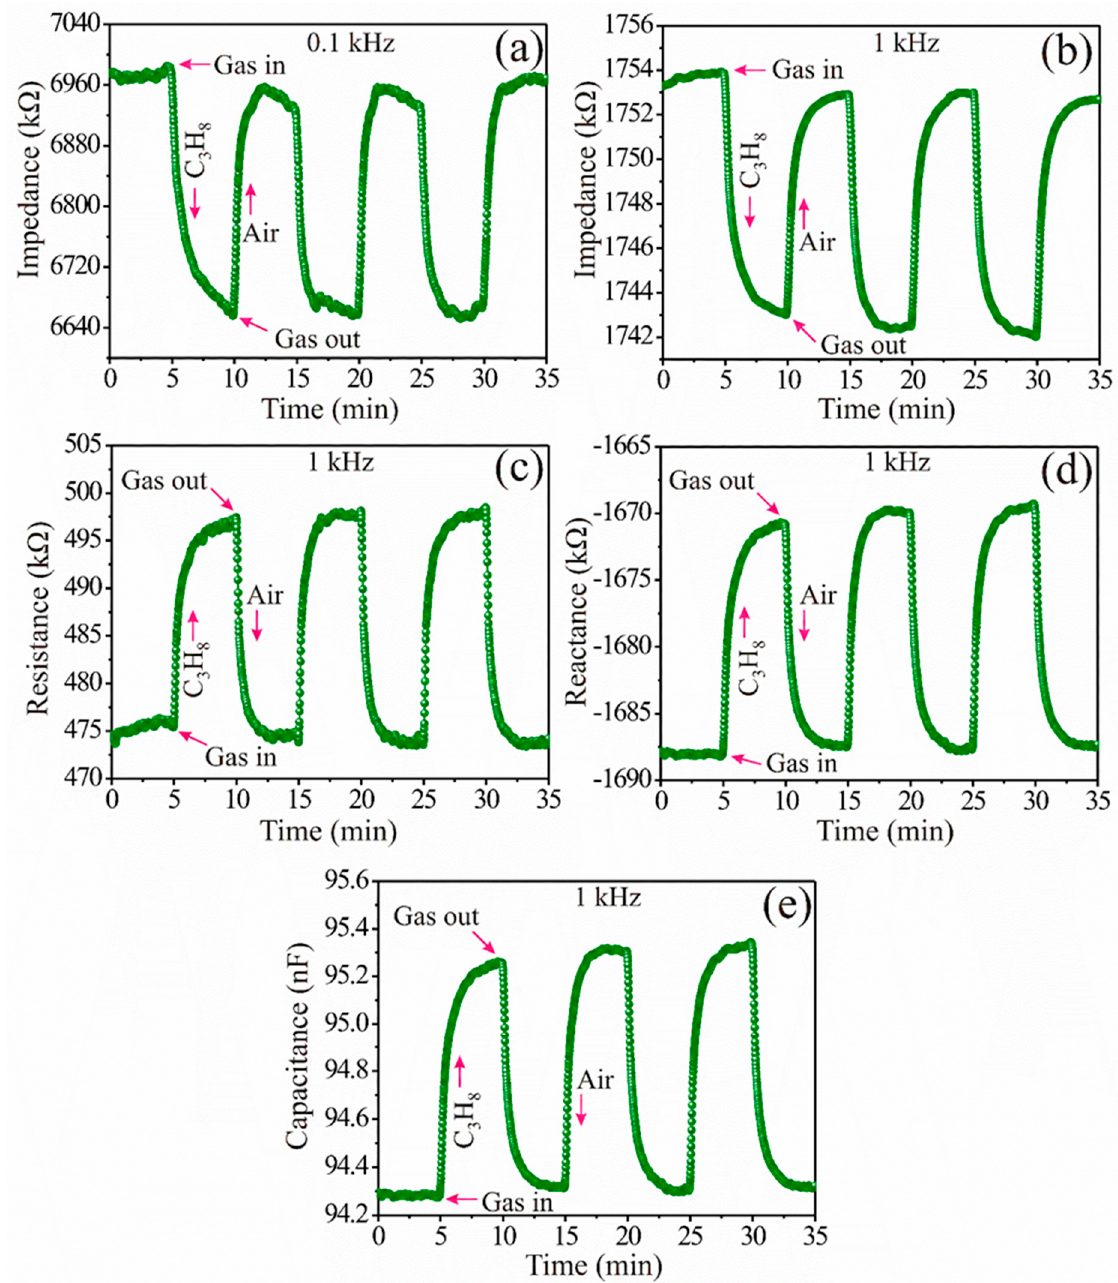
Figure 10. ( a , b ) Dynamic response at 0.1 and 1 kHz of NiSb 2 O 6 in 600 ppm of C 3 H 8 at 360 °C, ( c ‒ e ) resistance, reactance, and capacitance as a function of time at 1 kHz in 600 ppm of C 3 H 8 at 360 °C.